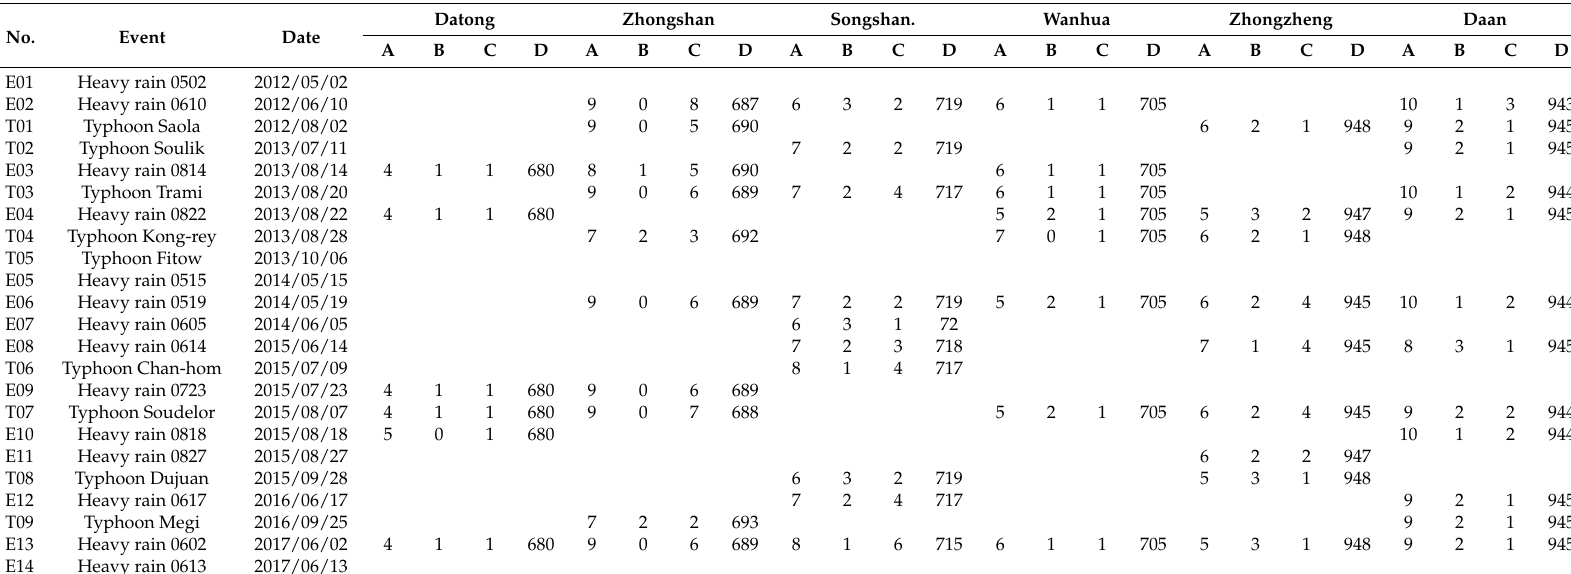
Table 10. Warning results of the cross test for the six